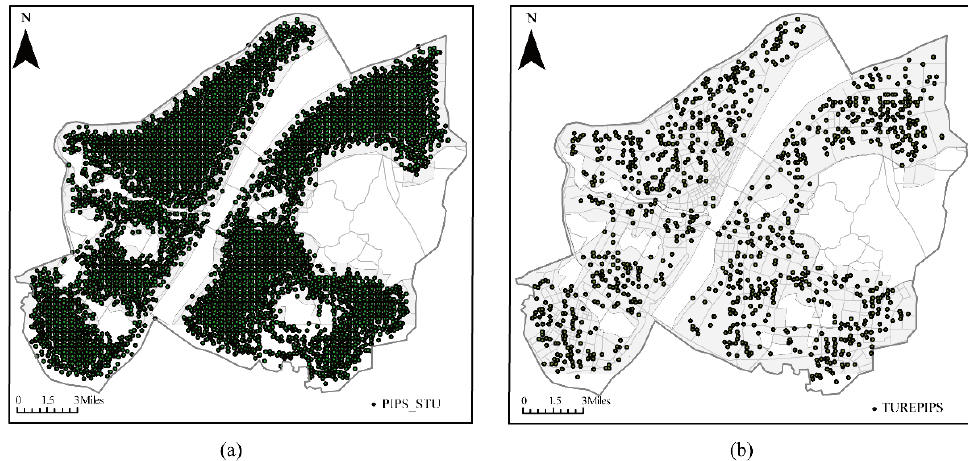
Figure 4. Candidate locations. ( a ) Locations determined by PIPS; ( b ) candidate locations including spatial constraints.